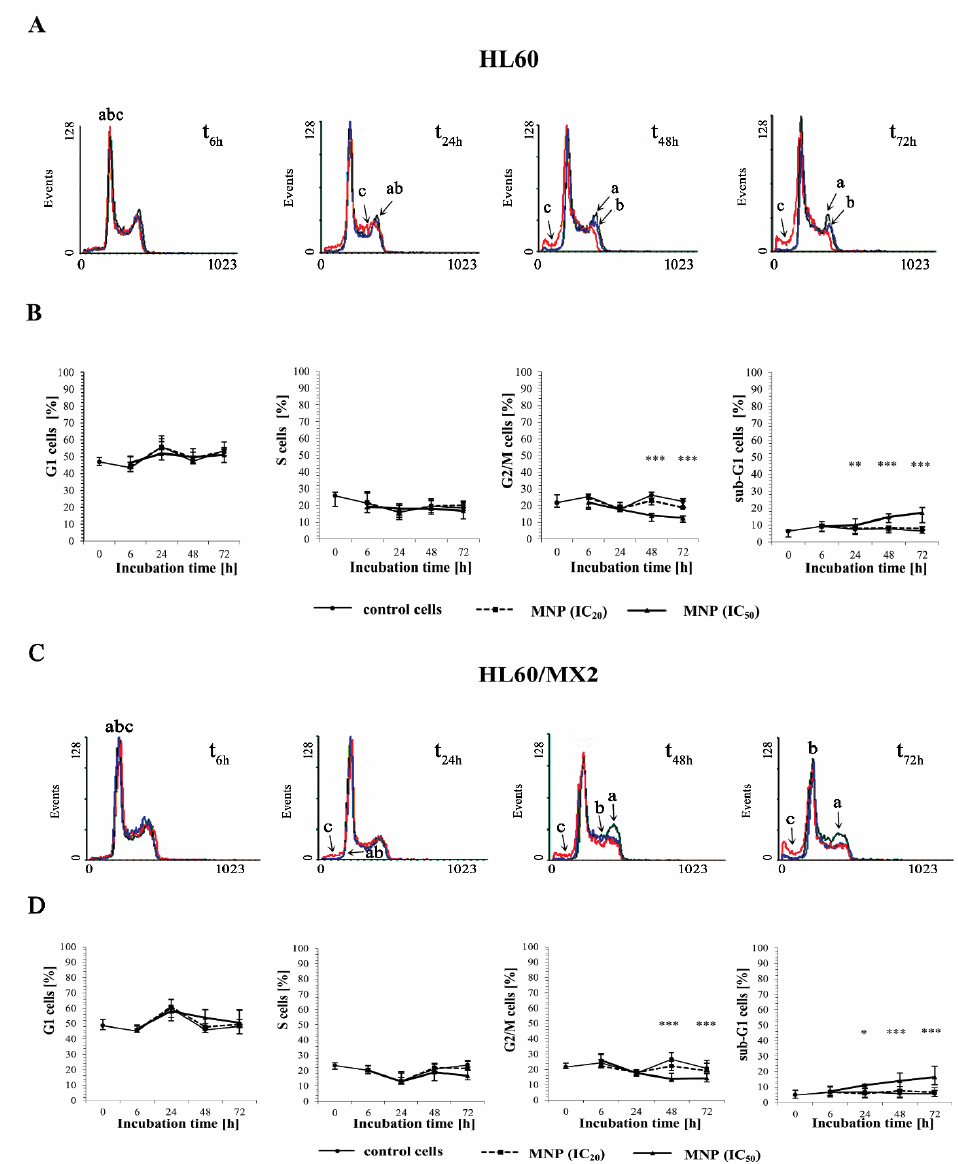
Figure 4. The effect of MNP on the cell cycle distribution in sensitive HL60 ( A , B ) and resistant HL60/MX2 ( C , D ) leukaemia cells and the appearance of subdiploid (sub-G1) cells with degradated DNA. The cells were incubated at 37 °C with MNP used at IC 20 (7.5 µM for HL60 cells and 7.2 µM for HL60/MX2 cells) or at IC 50 (24.3 µM for HL60 cells and 20.5 µM for HL60/MX2 cells), respectively, up to 72 h. The cell cycle distribution was analysed by flow cytometry (FACScan; Becton Dickinson). The red fluorescence (FL-2) of 10 4 events per sample was measured with the use of a laser beam at 585 ± 21 nm (λ ex = 488 nm) to determine the propidium iodide (PI) labelled DNA content. Presented histograms ( A , C ) are representative examples observed for the control and treated cell samples (a, black — control cells; b, blue — cells treated with MNP at IC 20 ; and c, red — cells treated with MNP at IC 50 ). The experiment was repeated at least four times (made in triplicate) and the data are given as median (interquartile range) values ( B , D ). The significance level of the differences observed (Mann – Whitney U test) between values found for cells treated with MNP at IC 50 (* p < 0.05; ** p < 0.01; *** p < 0.001) compared with values found for control cells.